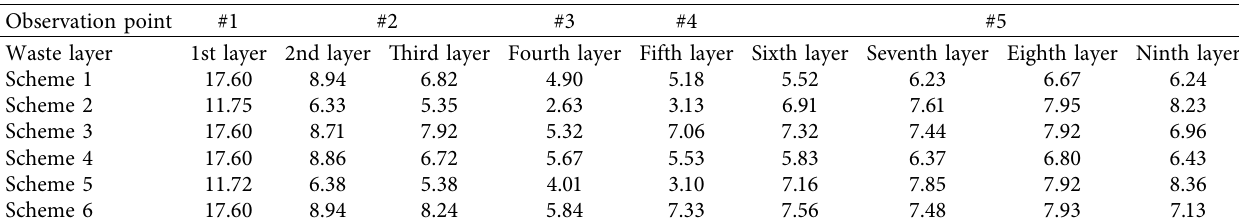
Table 6: Max. perched levels of all the schemes